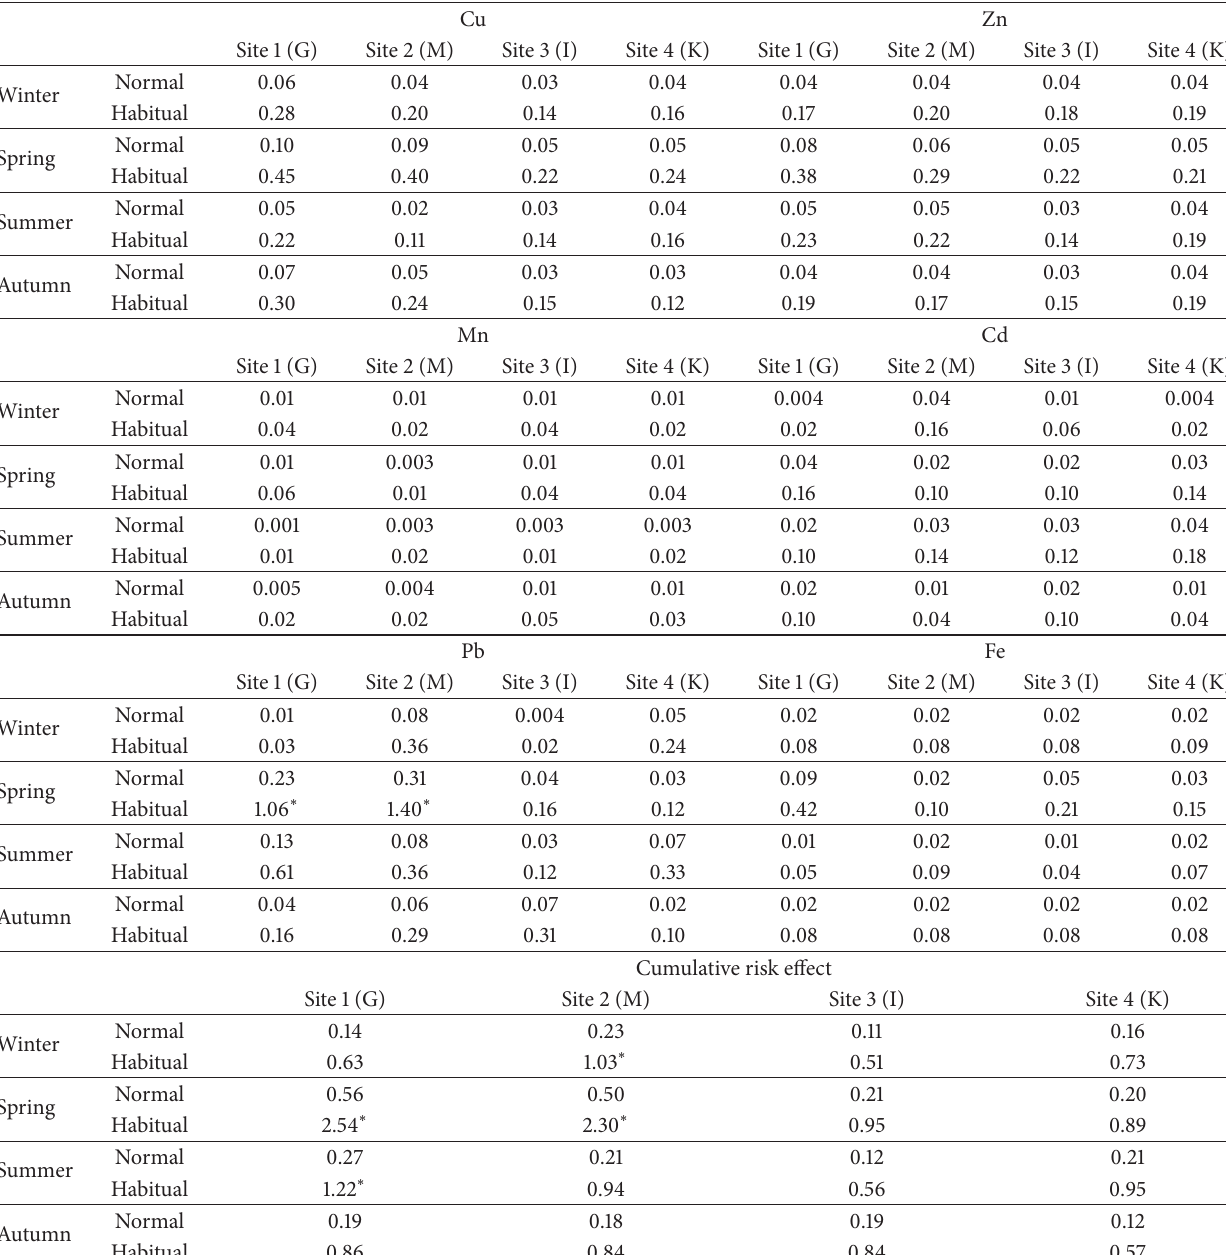
Table 5: Hazard index (HI) and the cumulative risk effect for normal and habitual fish